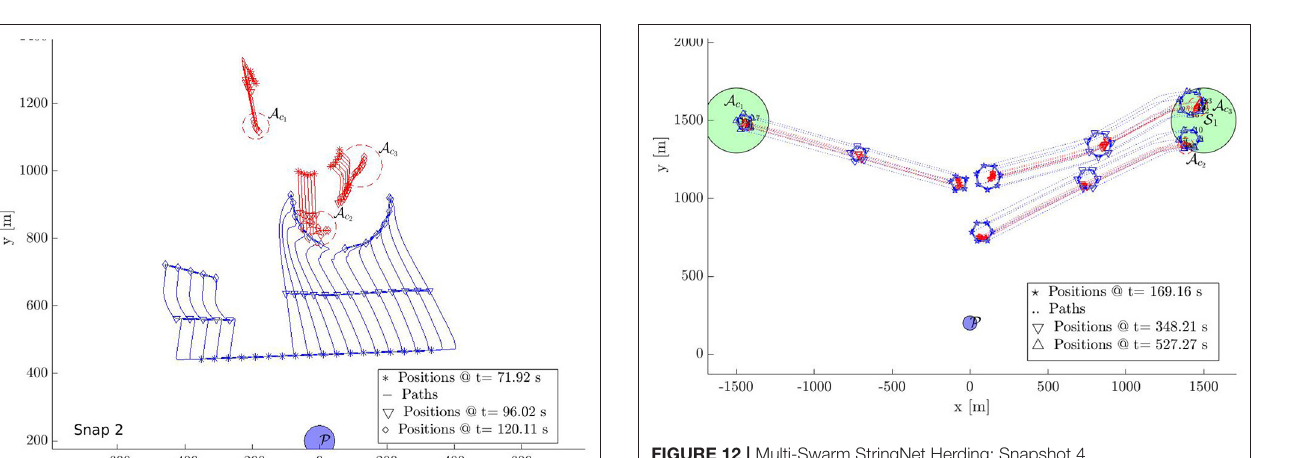
FIGURE 12 | Multi-Swarm StringNet Herding: Snapshot